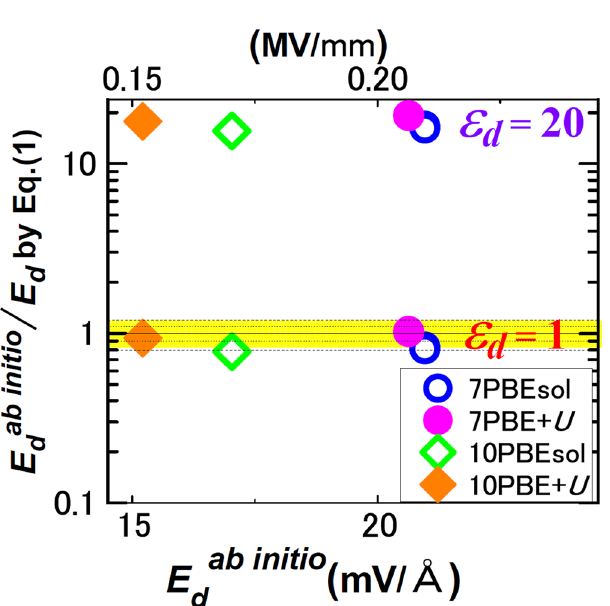
Figure 4. FE/paraelectric. Comparison of E dab initio with Eq. (1) with ε d = 1, 20 for BTO/5-unit-cell-STO. The yellow band shows the range of 1 ± 0.2, and the dotted lines inside of the band show the range of 1 ± 0.1. Inset explains the BTO thickness l f in unit-cells and ab initio method (PBEsol or PBE + U